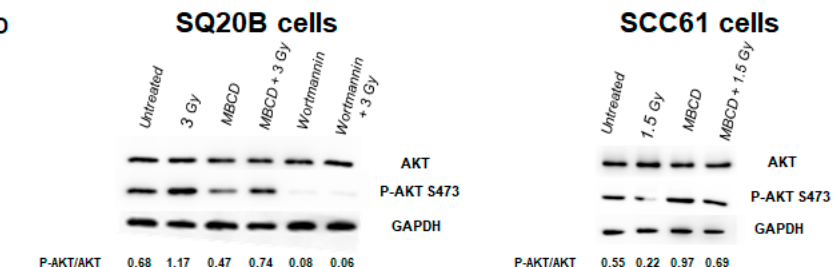
Figure 6. An endogenous AKT protein resides in lipid raft fractions of SQ20B cells and confers resistance to targeted and nontargeted e ff ects. ( A ) SQ20B cells treated without (untreated) or with MBCD were incubated with Alexa-488-conjugated cholera toxin B (CTxB) following incubation with p-AKT S473. ( B ) SQ20B cells were pretreated in the presence or absence of MBCD, and total cell lysates (upper panel) or fractions isolated from non-raft and raft domains (bottom panel) were subjected to SDS-PAGE followed by western blotting for p-AKT S473. ( C ) SQ20B cells were preincubated or not with the phosphatidylinositol-3-kinase (PI3K) inhibitor (0.5 µ M wortmannin) for 60 min followed by irradiation (donor cells) or CM from SQ20B donor cells (recipient cells), and clonogenic survival was determined. The results are the mean ± SD of three experiments performed in triplicate. * p < 0.05, ** p < 0.01, compared with cells treated only with radiation. ( D ) p-AKT S473 was expressed in total cell lysates of SQ20B and SCC61 cells in the presence or absence of MBCD or wortmannin.